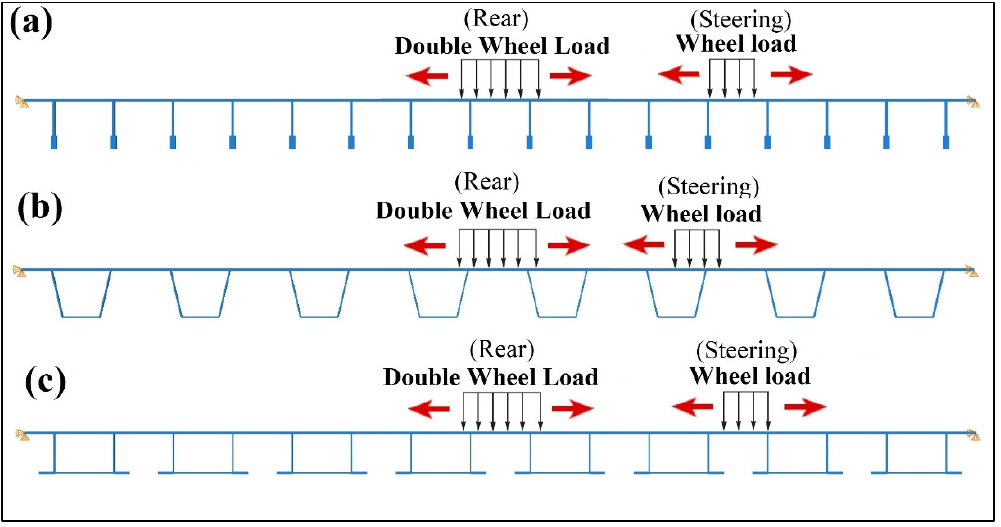
Figure 6. Influence line frame simulation: ( a ) Bulb section; ( b ) Trapezoidal section; ( c ) Built-up sec- tion.